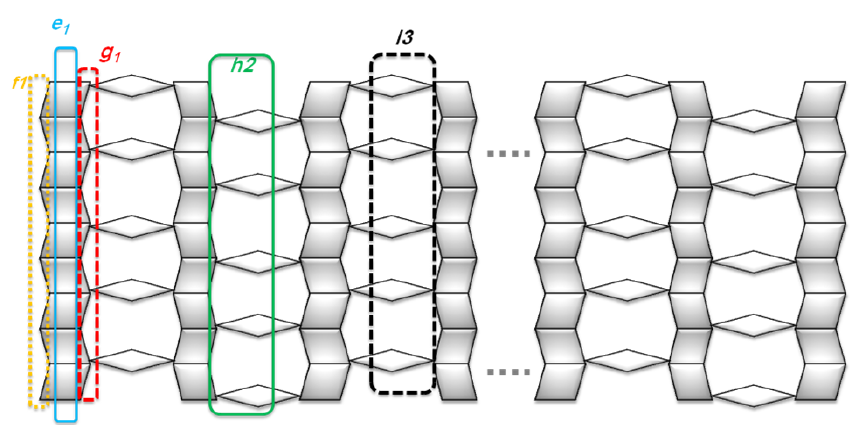
Fig. 2 Categories for edges of the Titania Carbon